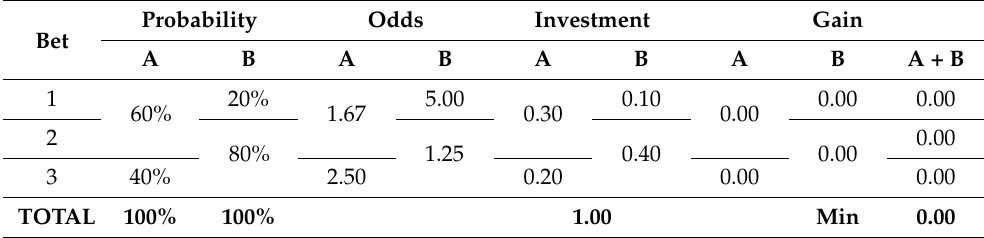
Table 6. Unreconciled quotes that do not allow